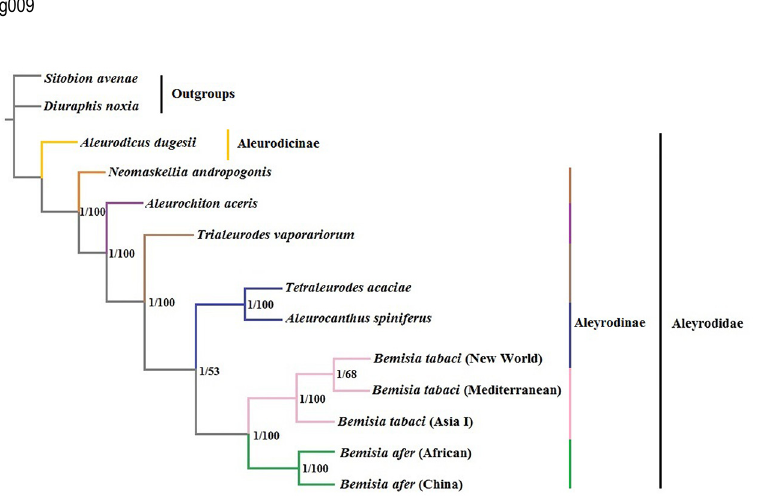
Fig 10. Inferred phylogenetic relationships among Aleyrodidae based on the 13 PCGs. Numbers at the nodes are Bayesian posterior probabilities (left) and ML bootstrap values (right). The tree was rooted with two outgroups ( S . avenae and D . noxia